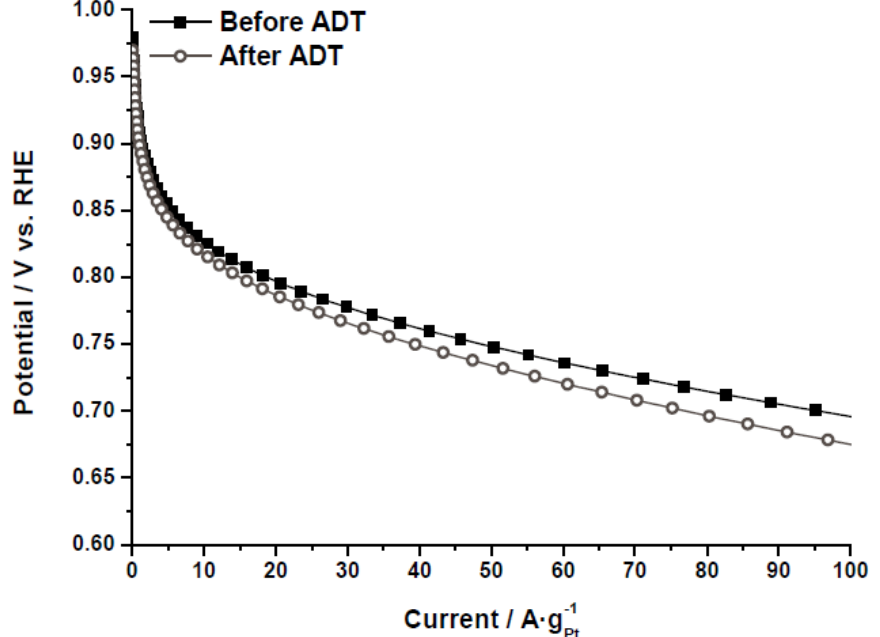
Figure 8. Polarization curves (half-cell, oxygen fed, 0.5 M H accelerated degradation tests (ADT) for the catalyst